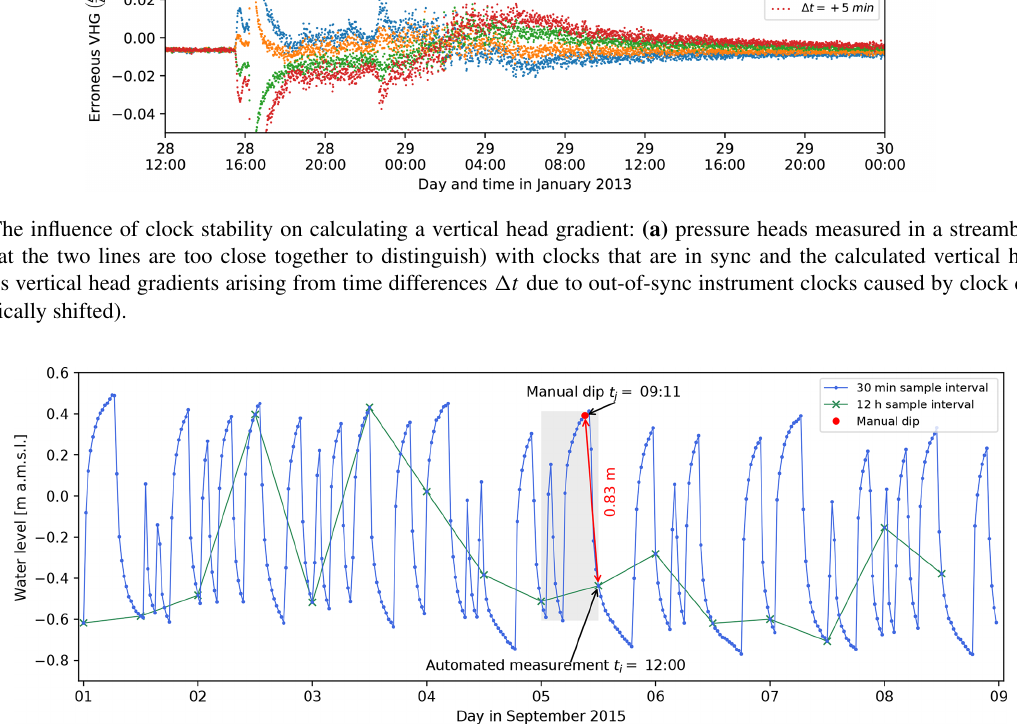
Figure 11. Water level in an observation well responding to irregular and frequent pumping from a nearby production bore automatically measured at two different sampling intervals (12h or 30min). Note that a manual dip which is taken at a time that falls between sam- ples of automated measurement (e.g., the time period indicated by the grey box) can result in a significant measurement error in dynamic hydrogeological